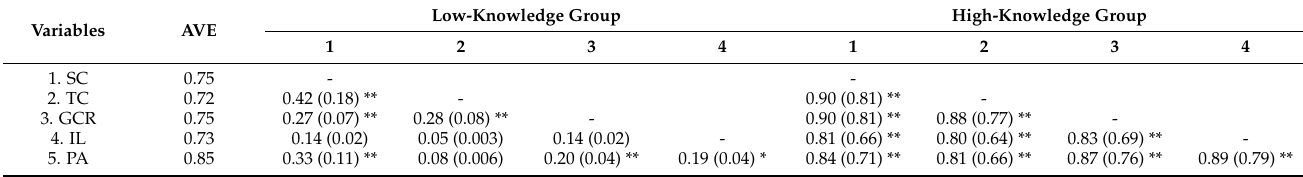
Table 3. Correlations ( r ) and coefficient determinations ( r 2